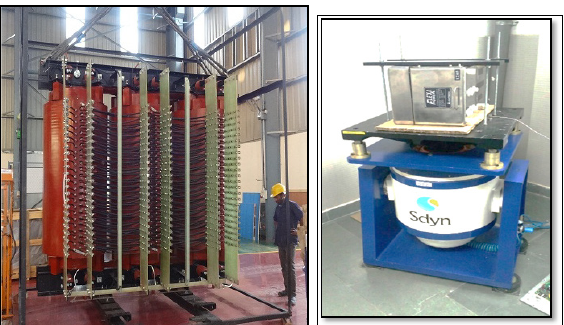
Fig. 4 : Multi-secondary Transformer & 80kW SPS module mounted on test bench